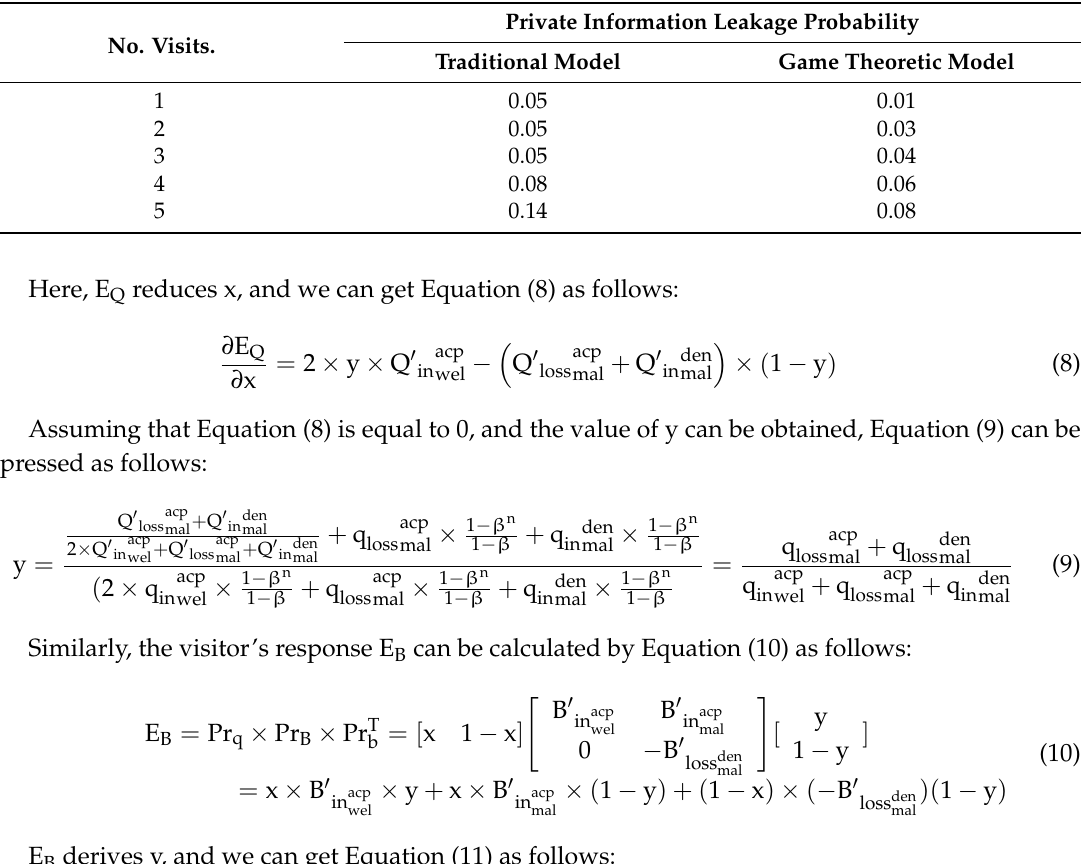
Table 4. Number of visits and private information leakage